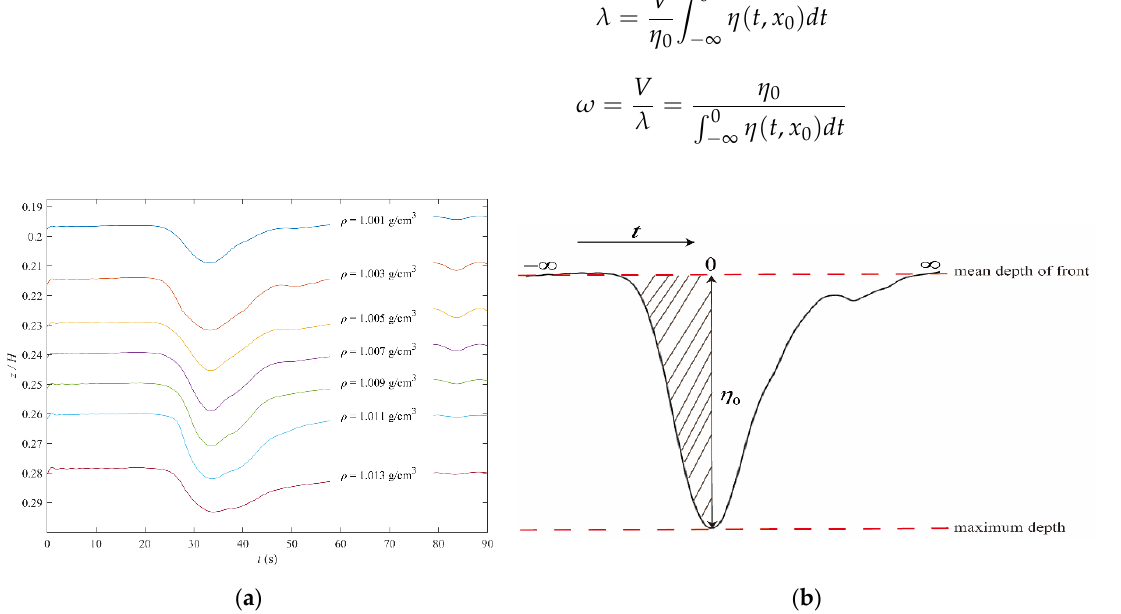
Figure 2. Vertical distribution of isopycnic lines of ISWs in a certain stratification ( a ) and experimental method of calculating the amplitude and characteristic frequency of ISWs ( b ).